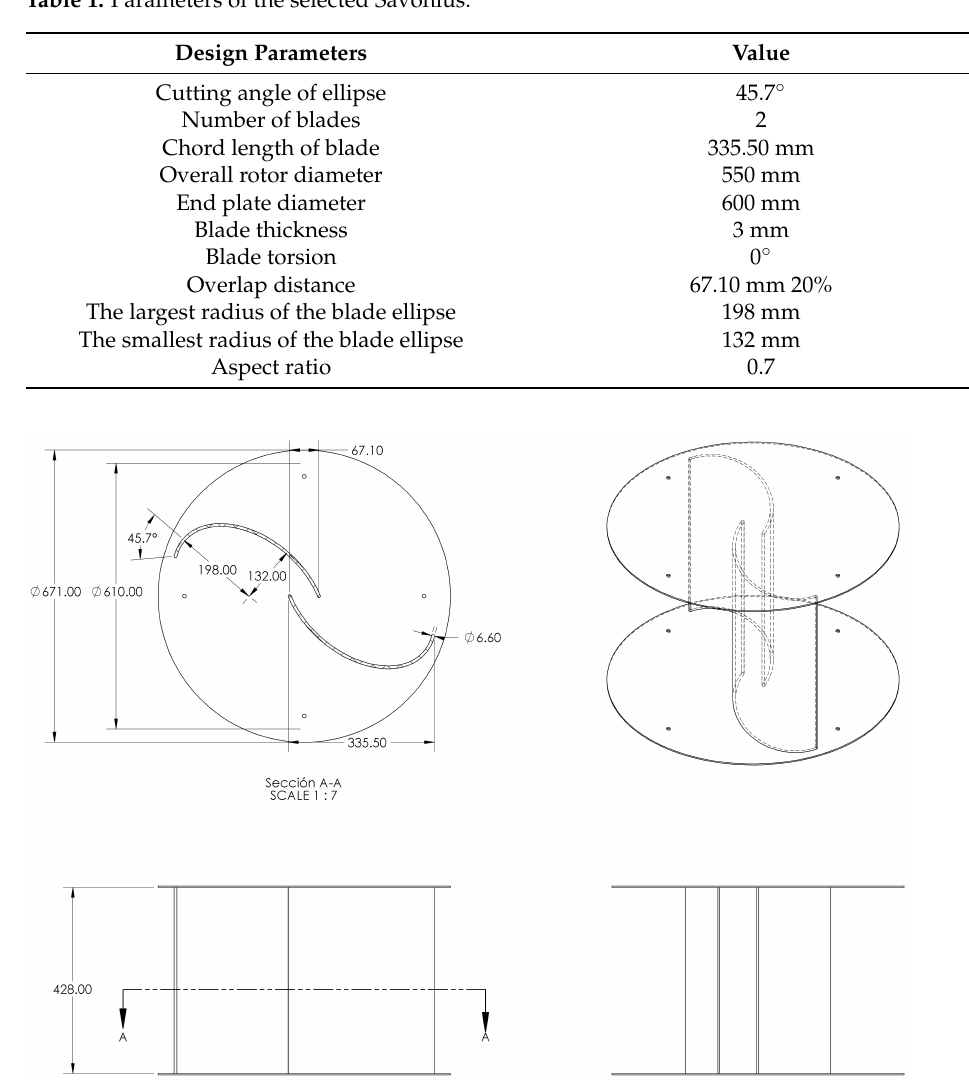
Figure 3. Savonius final